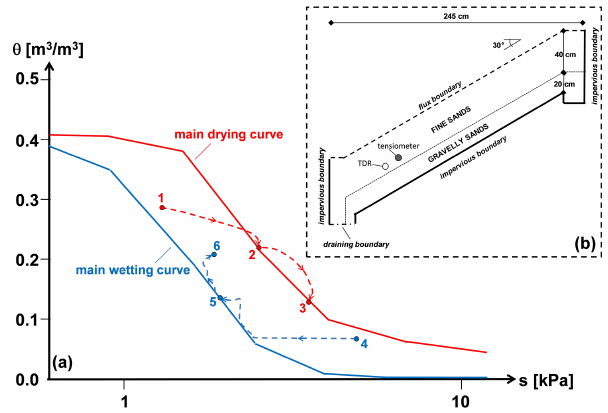
Figure 2. Scanning curves (a) obtained from flume tests carried out by Tami et al. (2004) during two consecutive drying stages (1–2, 2– 3) and wetting stages (4–5, 5–6). The 30 ◦ inclined model slope (b) consists of a 40cm thick layer of fine sands that overlies a 20cm thick layer of gravelly sands. The volumetric water content, θ , and the matric suction, s , are respectively measured by a time domain reflectometry (TDR) probe and a tensiometer, both installed at a depth of 30cm. The main drying curve and the main wetting curve have been obtained through a Tempe cell and capillary rise